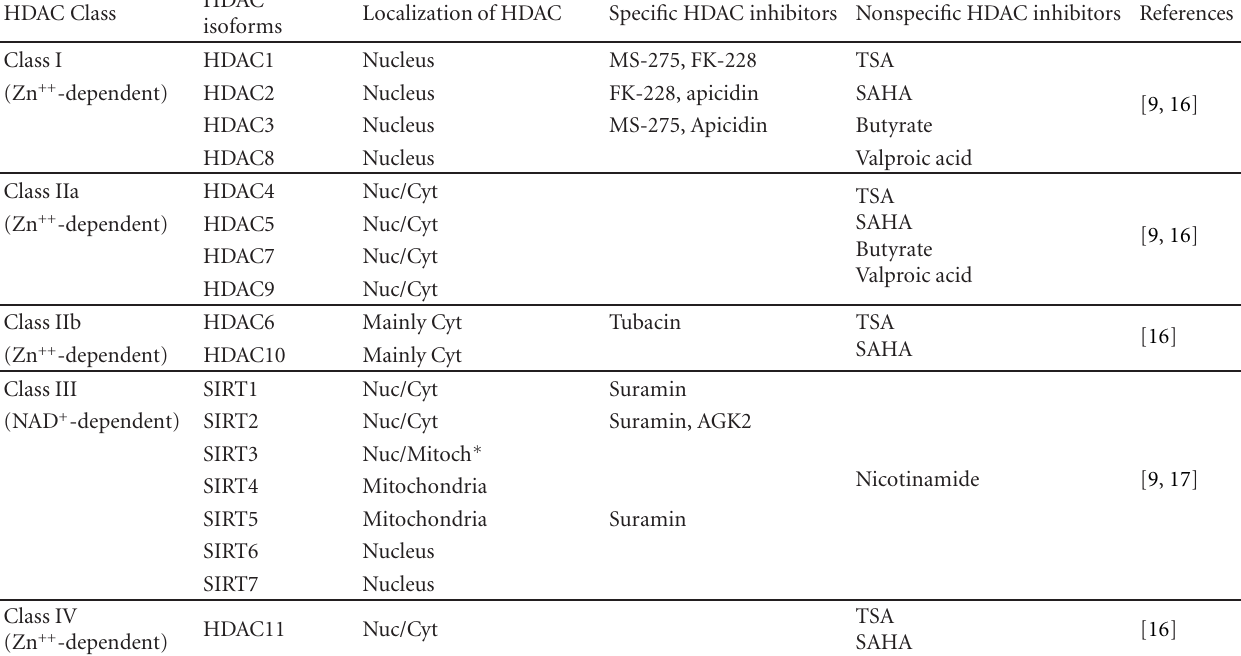
Table 1: Classification of HDACs and selected